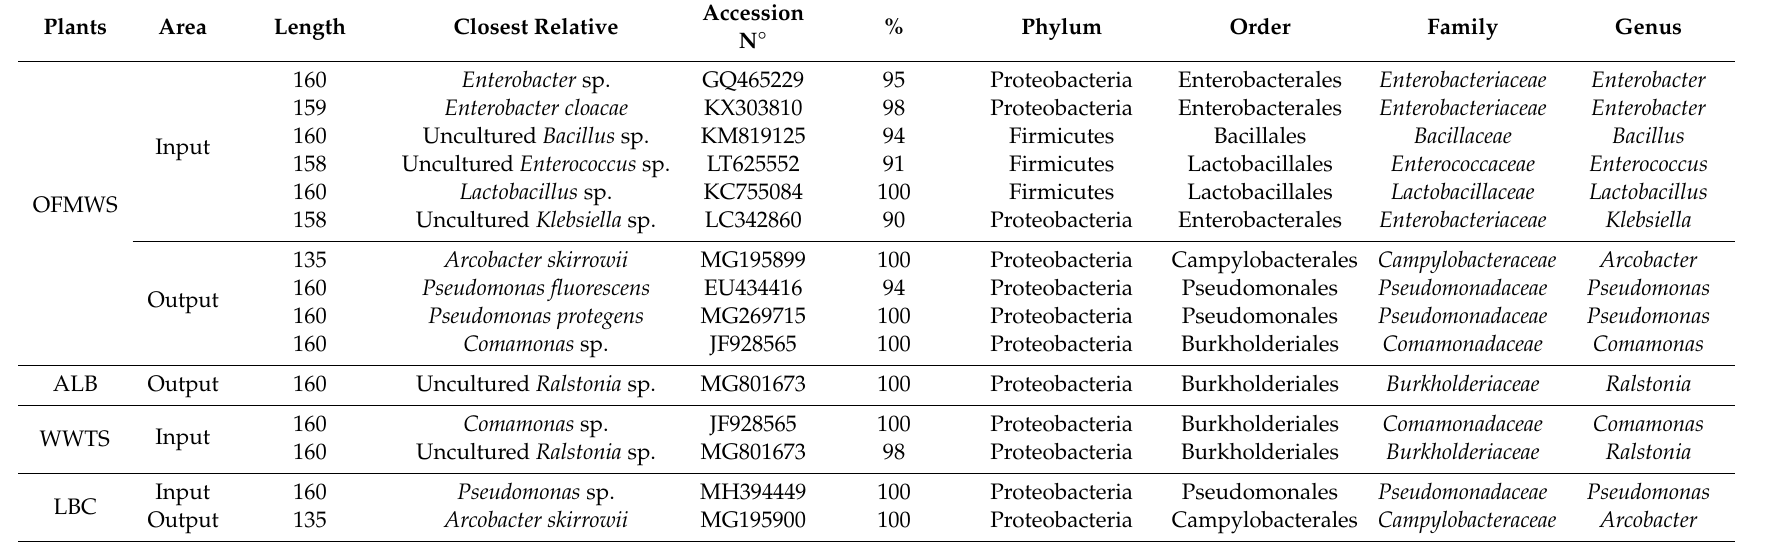
Table 4. Taxonomic assignment of sequencing reads from the bacteria community (16S rRNA) of bioaerosol samples for each plant type.